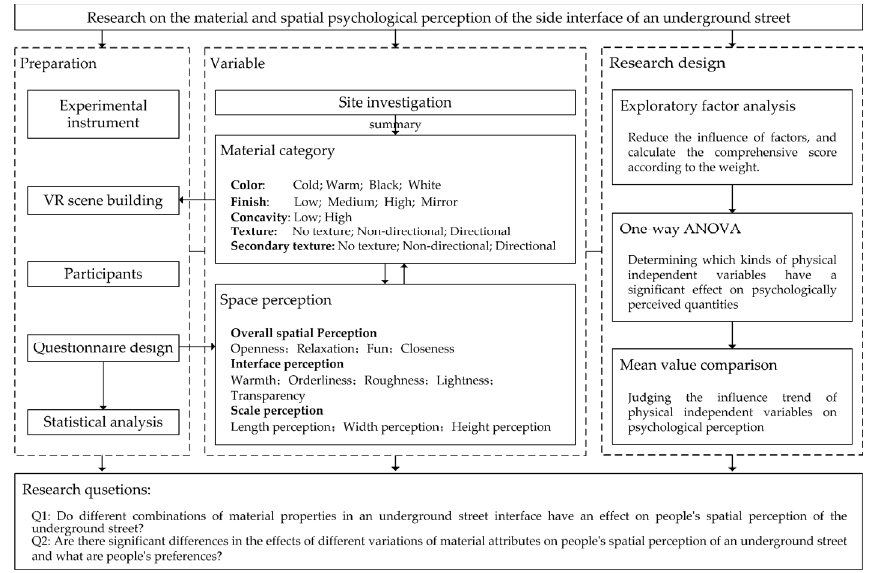
Figure 1. Research Framework .